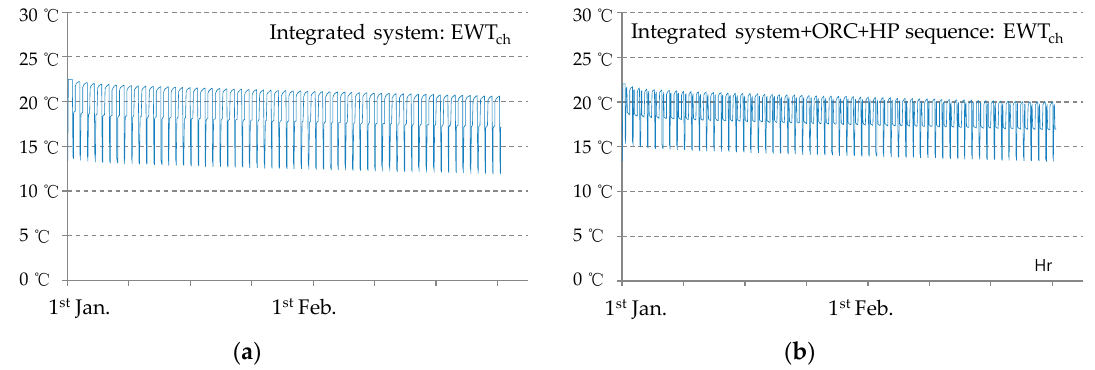
Figure 8. ( a ) EWT ch of the integrated system; ( b ) that with OARC in sequential operationduring January and February.